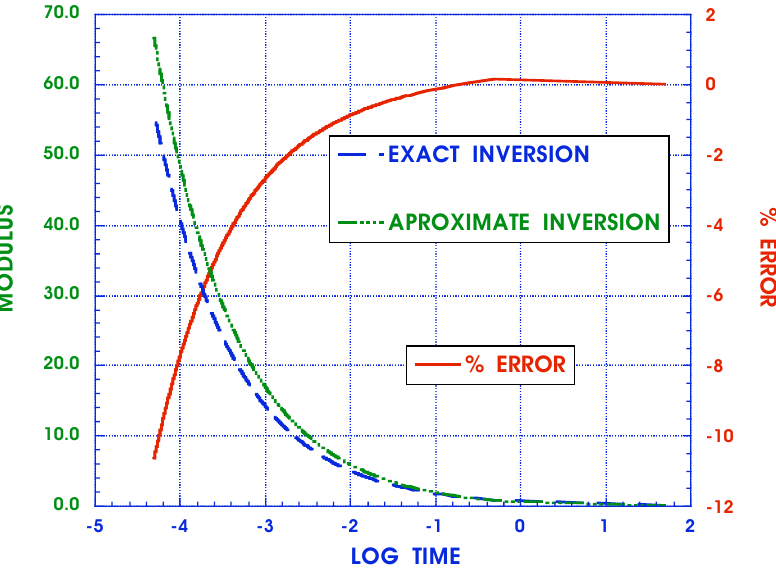
Figure 5. Comparison of ID and FT modeling of 1 / ( p + c ) µ .